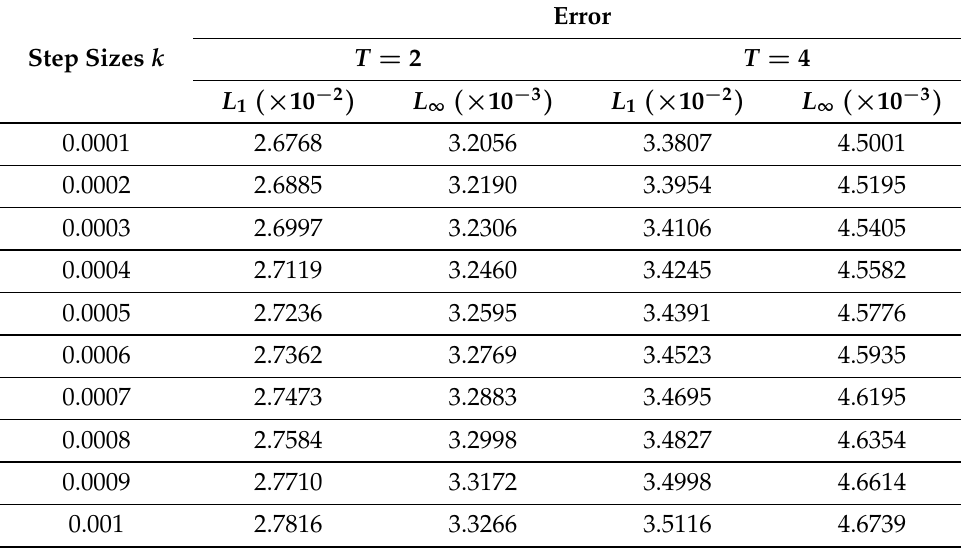
Table 5. L 1 and L ∞ errors for various k when h = π /10 when Scheme 2 is employed to approximate Numerical Experiment 2 at T = 2 and T = 4.